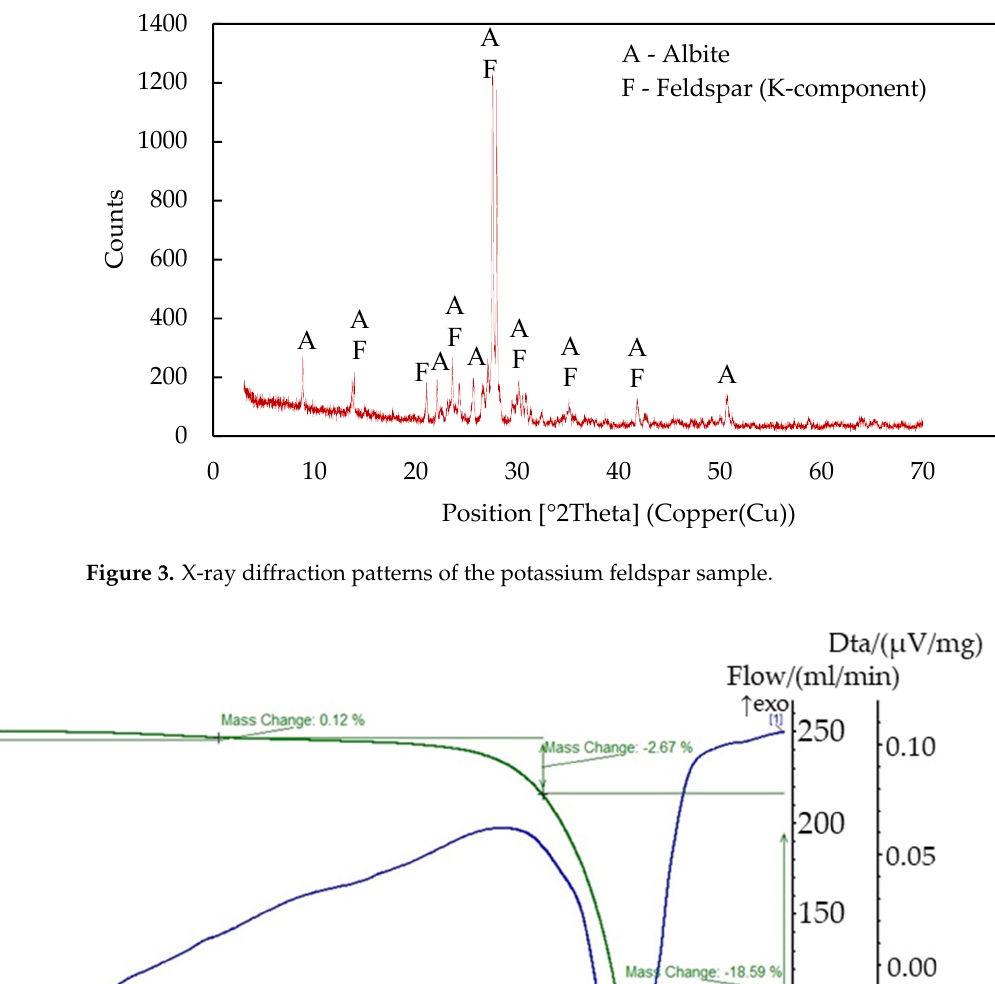
Figure 3. X-ray diffraction patterns of the potassium feldspar sample.